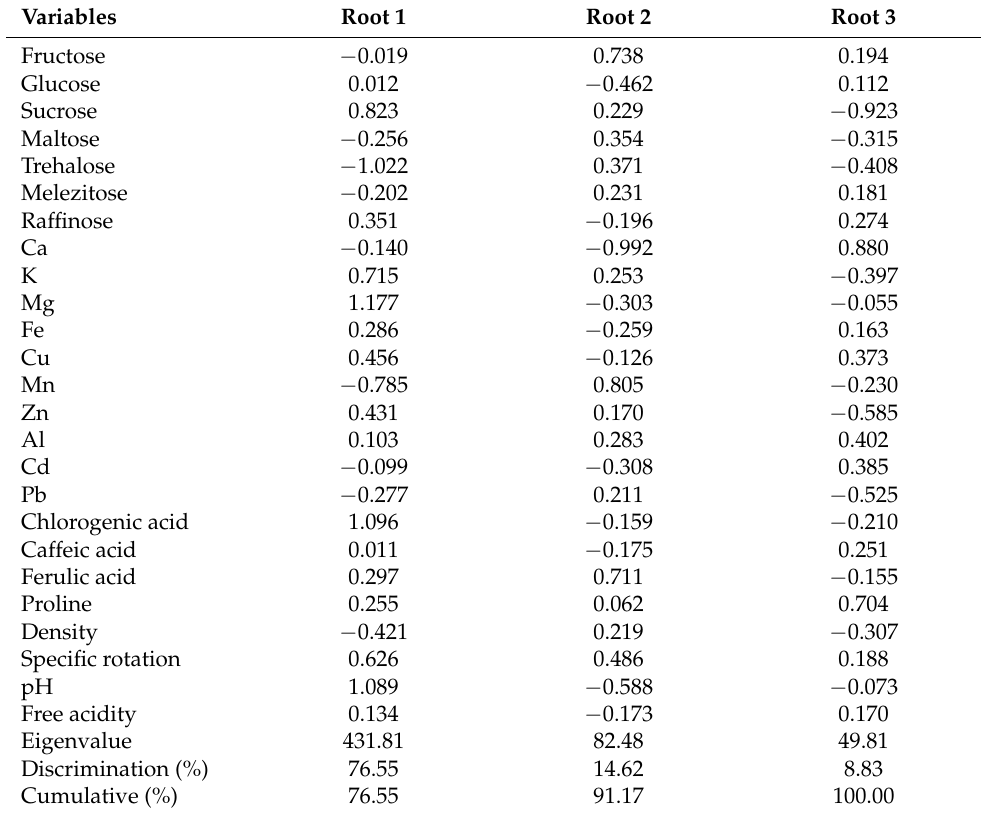
Table 4. Standardized canonical discriminant function coefficients.